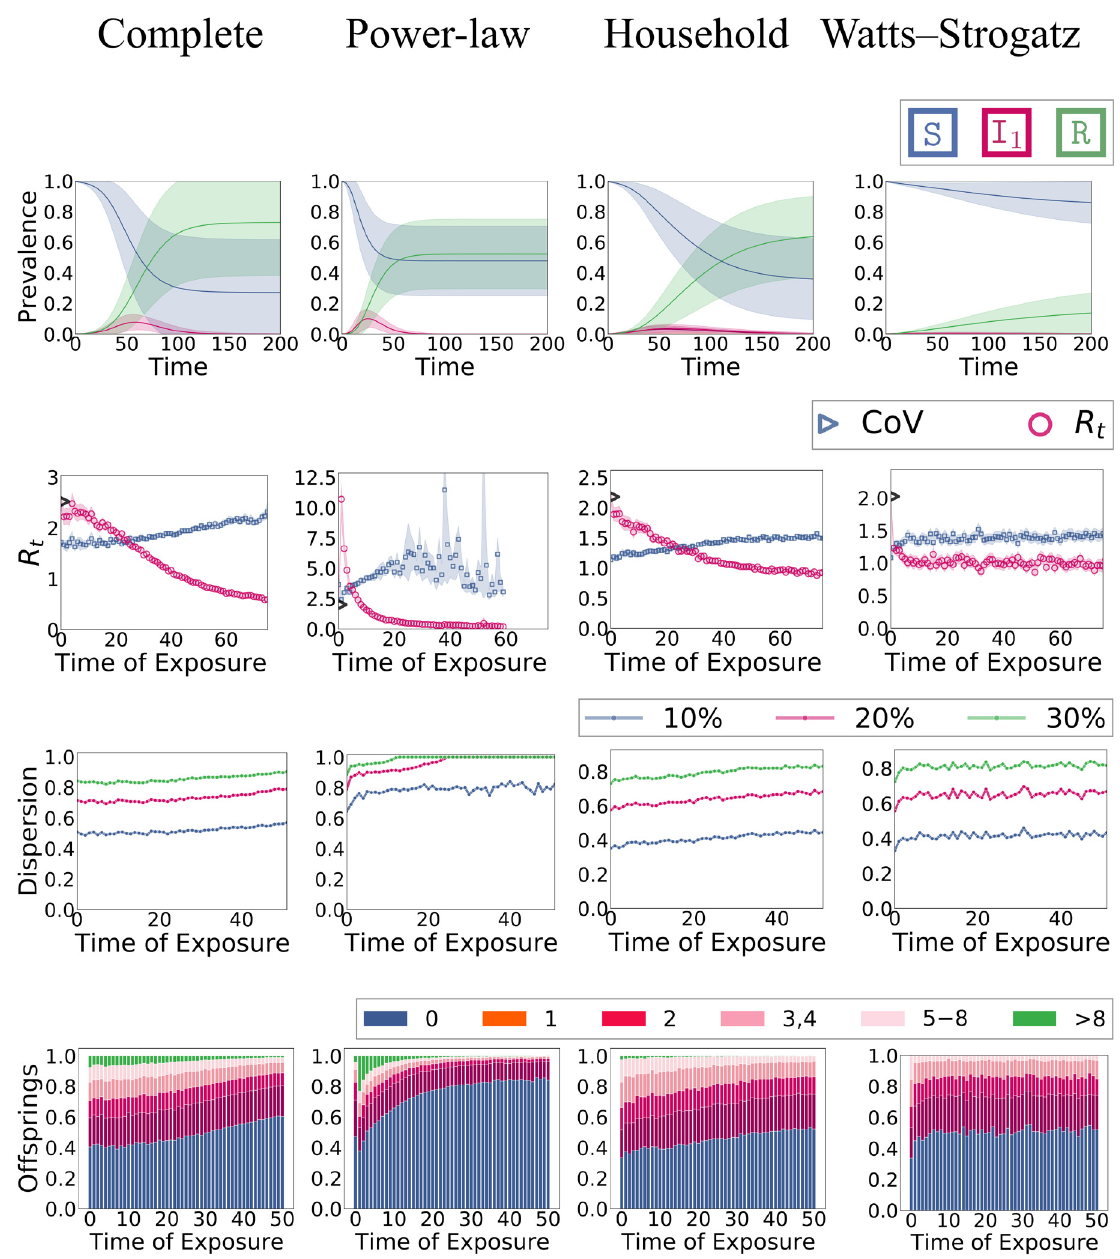
Fig 8. Experiment 2: Epidemic dynamics with individual infectiousness λ i . Row 1 : Evolution in terms of mean fractions in each and coefficient of variance of the offspring distribution. Row 3 : Top- k compartment over time Row 2 : Effective reproduction number R t plots: what fraction of new infection can be attributed to which fraction of infected nodes. Row 4 : Characterization of the offspring distribution in terms of what fraction of nodes have how many offspring (infect how many neighbors).